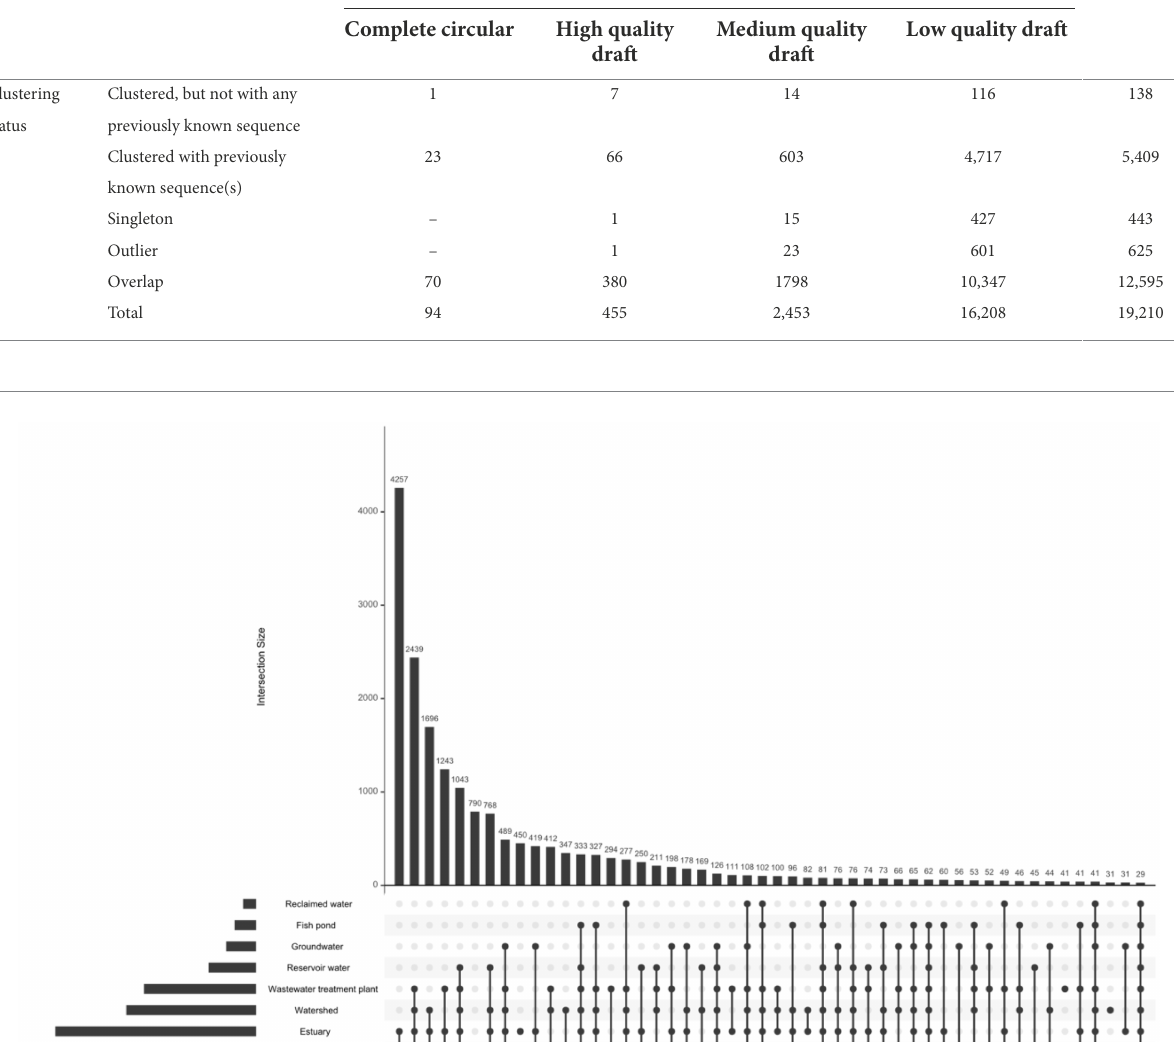
TABLE 2 Genome quality versus clustering status.